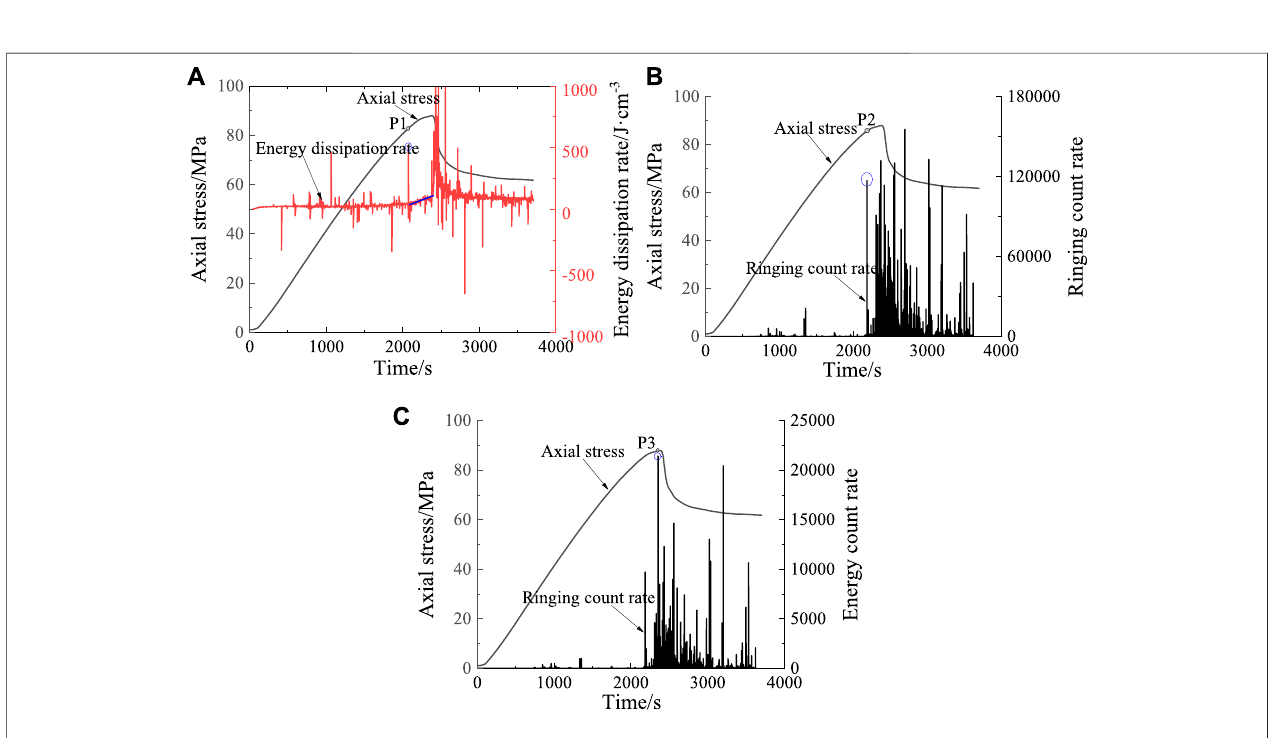
FIGURE 10 | Identi fi cation of failure precursor points. (A) P1, (B) P2, (C) P3.